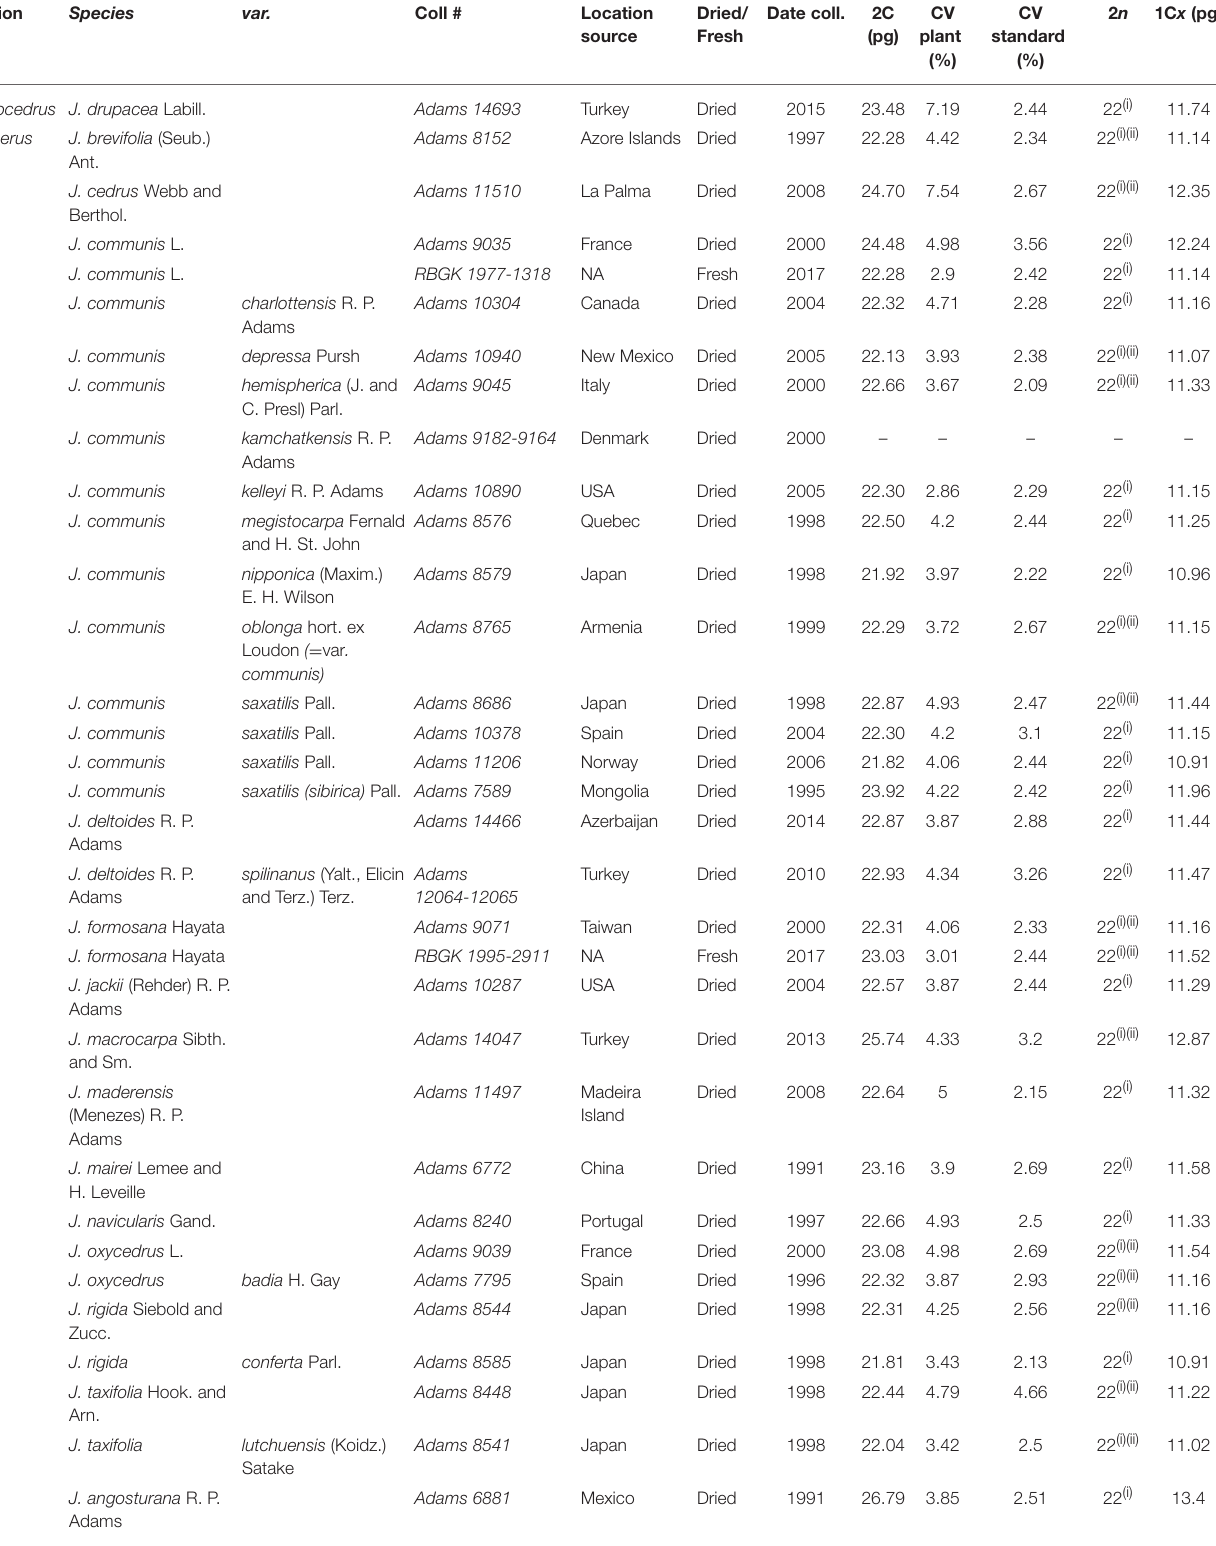
TABLE 1 | List of the Juniperus taxa studied with indication of data collection, type of material, genome size data, and chromosome numbers. Section